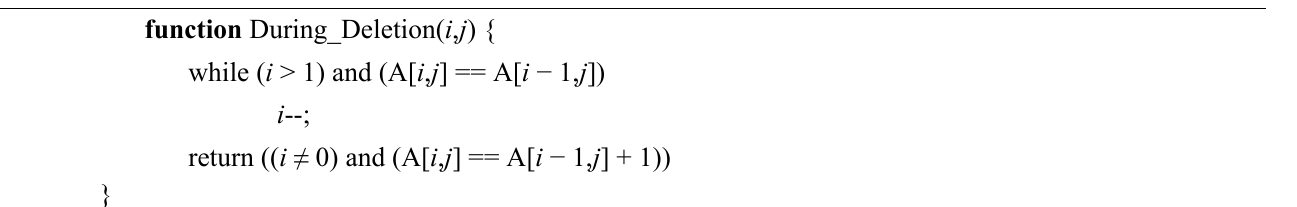
Algorithm 1. During_Deletion function—returns whether cell ( i , j ) is involved in a block